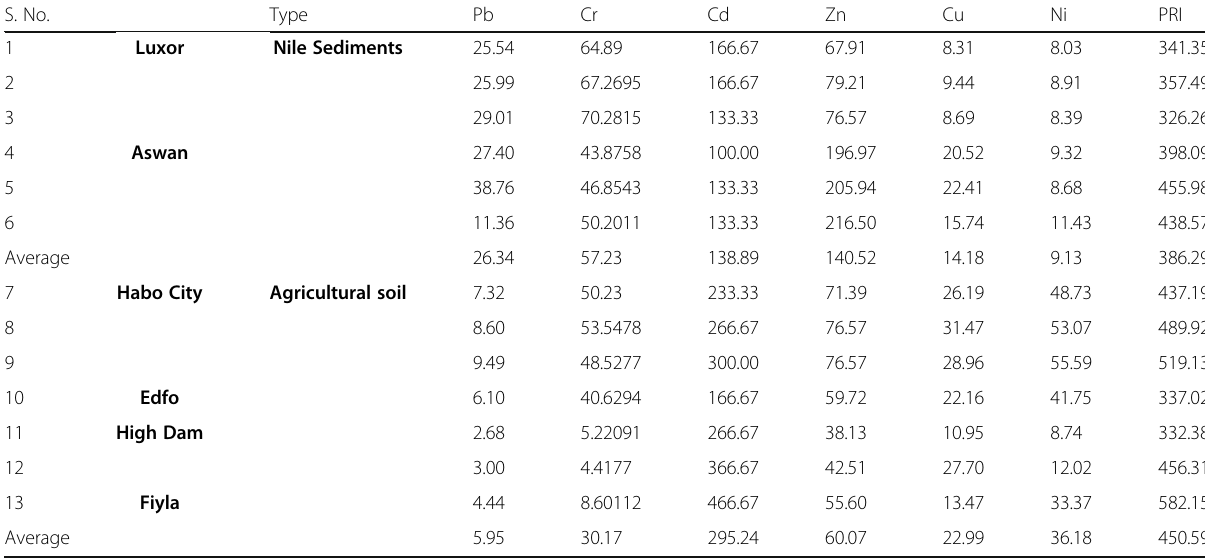
Table 5 Ecological risk factor (Er) and pollution ecological risk index (PRI) of the study samples S.